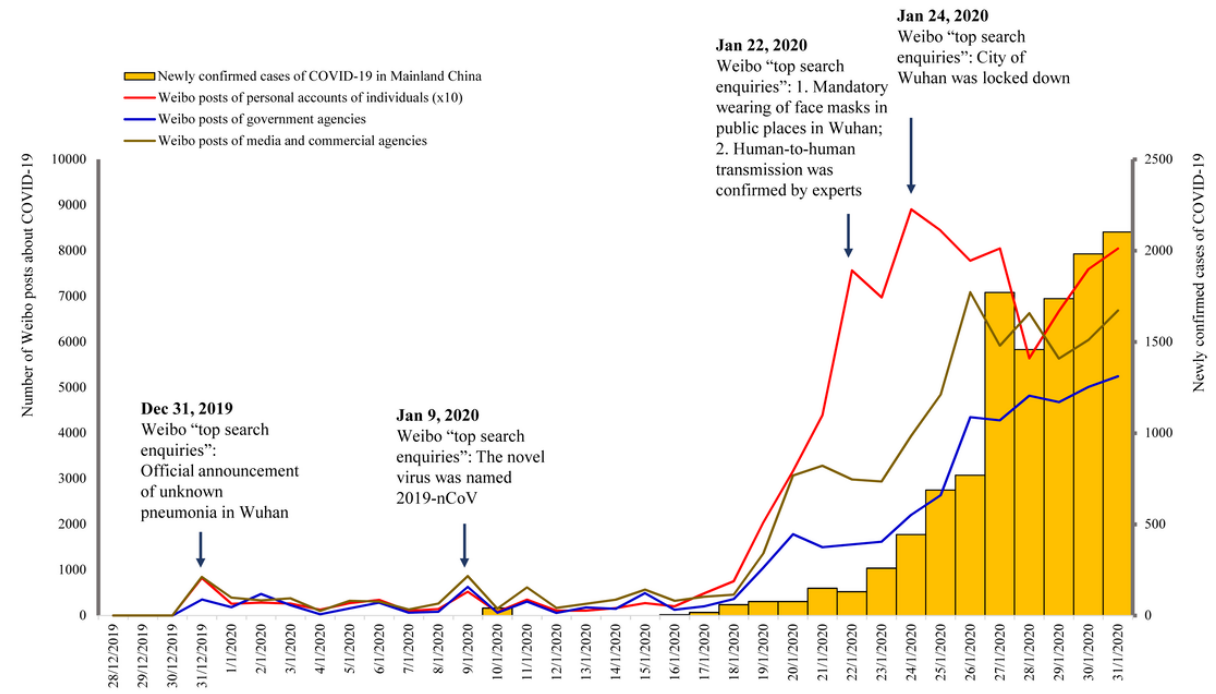
Figure 1. Daily numbers of newly confirmed cases of COVID-19 in Mainland China, daily numbers of Sina Weibo posts relevant to COVID-19 by account, and Weibo “top search enquiries” on peak days from December 2019 to January 2020. COVID-19: coronavirus disease; 2019-nCoV: novel